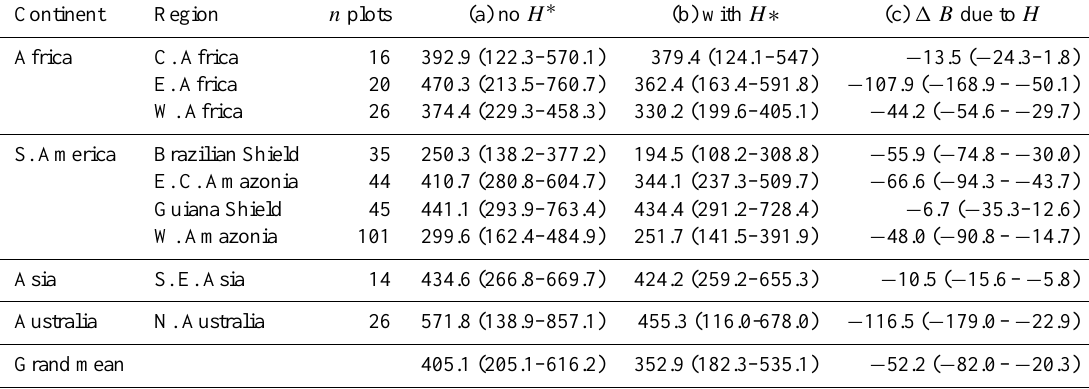
Table 4. Pantropical live tree aboveground dry biomass ( B ) estimates (mean (Mgha − 1 ) and bootstrapped 95% CI) when calculated as column (a) biomass estimated as per most published studies excluding H using our recalculation of the Chave et al. (2005) model with new published data; (b) biomass estimated based on height ( H ) integration from a regional H model; and (c) the difference (b–a) in biomass due to H integration for 327 plots.